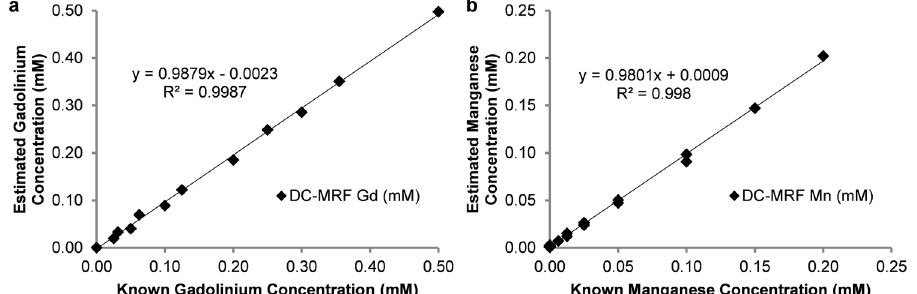
Figure 5. Pearson correlation plots of mean DC-MRF estimates for ( a ) gadolinium (Gd), and ( b ) manganese (Mn) concentration versus known phantom concentrations (n = 17). Mean DC-MRF concentration estimates were obtained from an ROI analysis of the MRF-based T1 and T2 relaxation time maps. The gadolinium and manganese concentrations were calculated for each of the MRF scans (n = 12) and averaged to calculate the mean DC-MRF concentration estimates shown in the plots. The mean DC-MRF concentration estimates resulted in a significant correlation over all phantoms (Pearson Correlations: R 2 > 0.998, p < 0.0001). Note also that the slopes of the correlations are nearly equal to 1 (0.988 and 0.980 for Gd and Mn, respectively) indicative of limited bias in the DC-MRF